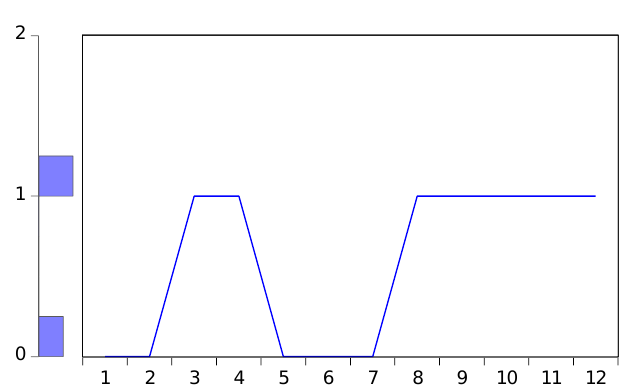
Figure 6. CSR sustainability reporting. SE R I ES 02